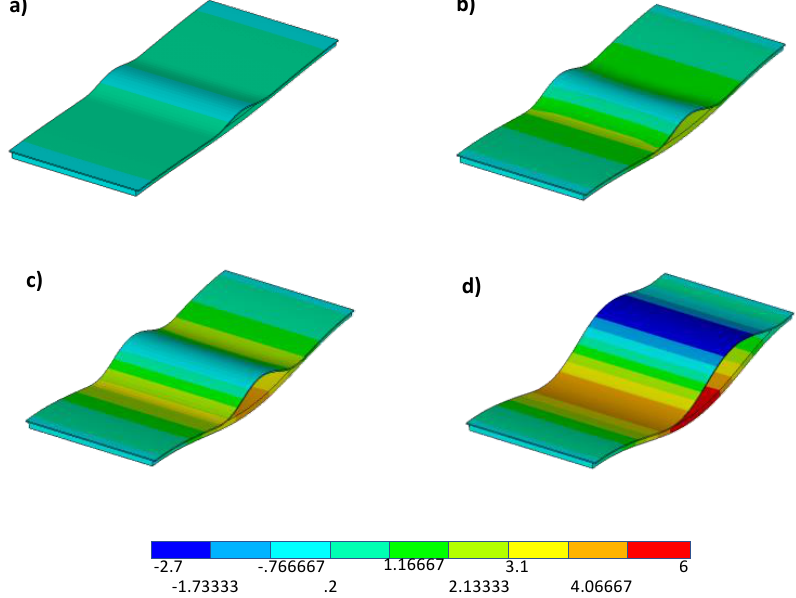
Figure 22. Numerical out-of-plane displacement contour plot for material sensitive to fibre bridging (units in mm) at ( a ) 0.3 mm applied displacement, ( b ) 0.4 mm applied displacement, ( c ) 0.55625 mm applied displacement, and ( d ) 0.73125 mm applied displacement.